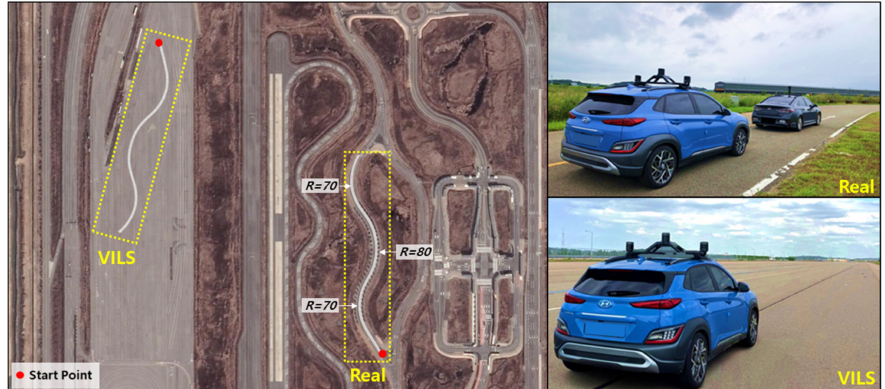
Figure 15. Test field KATRI K-City (Real) and proving ground (VILS).